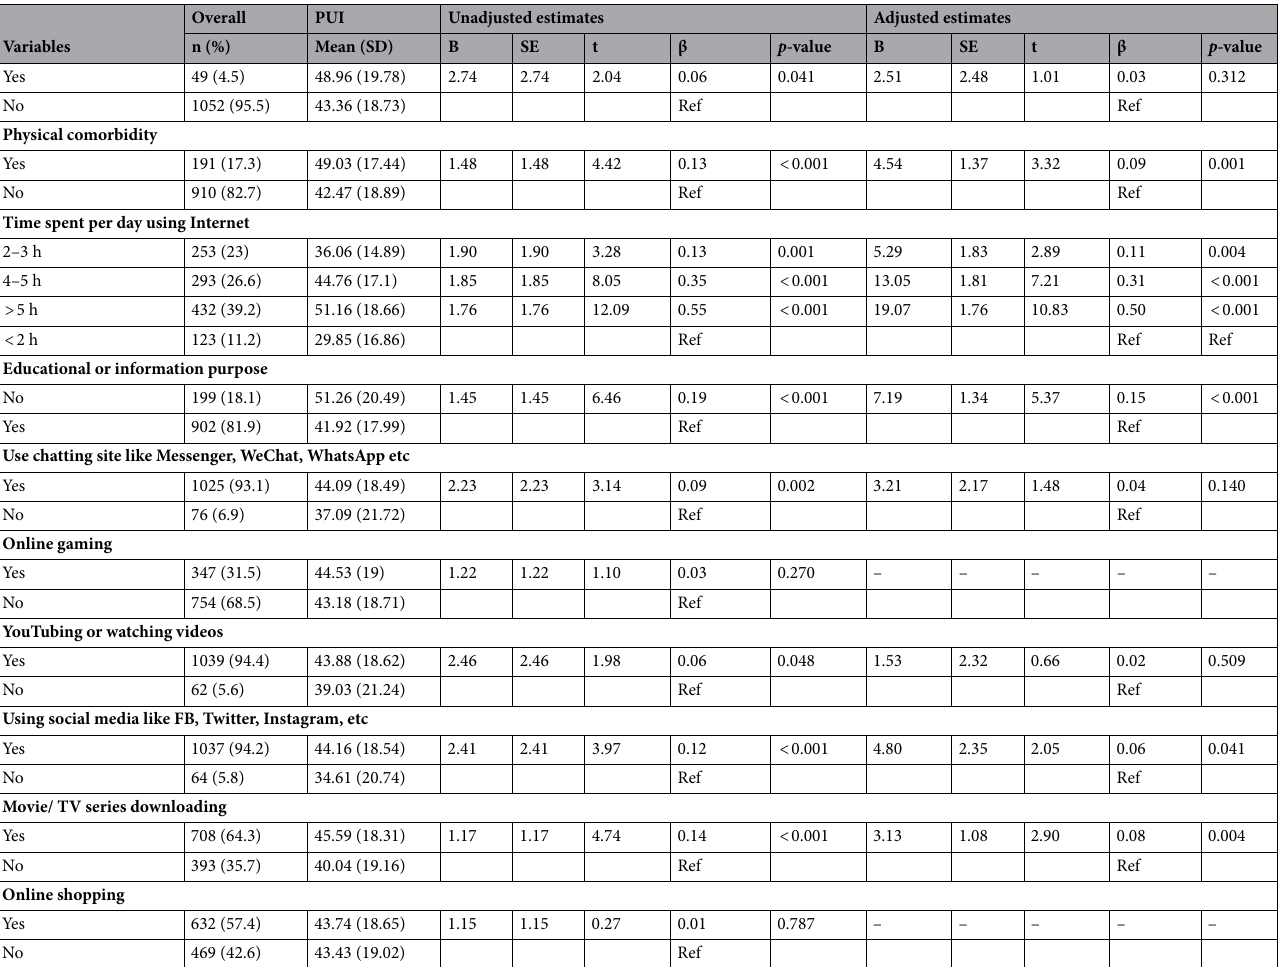
Table 1. Distribution of variables and regression analysis for PUI. SD Standard deviations; B unstandardized regression coefficient; SE Standard error; β standardized regression coefficient.